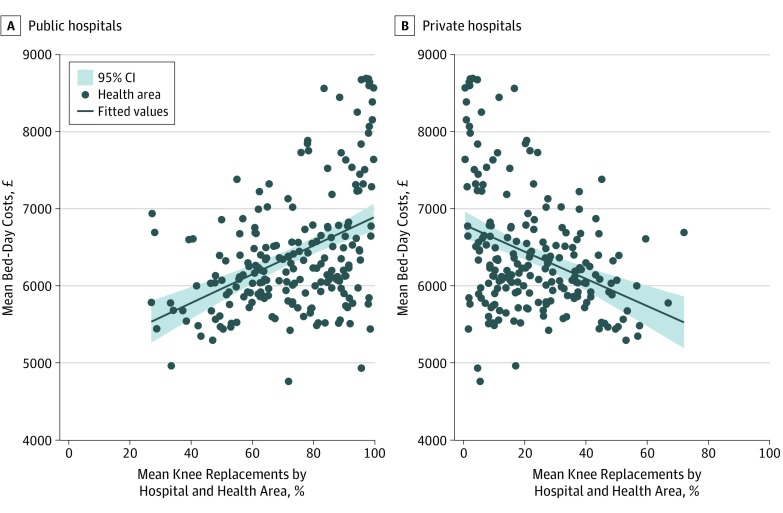
Correlation Between Bed-Day Costs and Percentage of Knee Replacements in Public and Private Hospitals by Health Area in England, 2014-2016To convert pounds sterling to US dollars, multiply by 1.23.